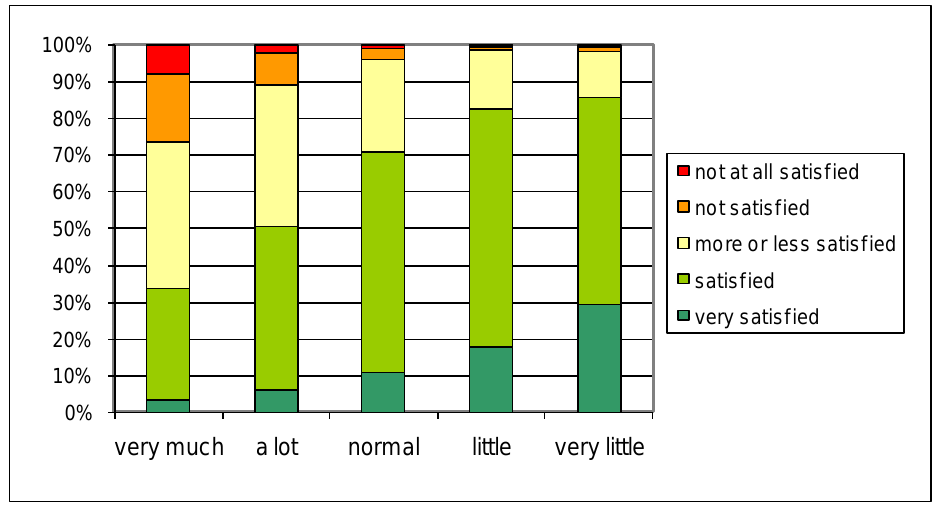
Figure 6. The effect of reported traffic intensity in the neighborhood (Q1.8) (horizontal) on global living quality in the neighborhood (Q1.1)